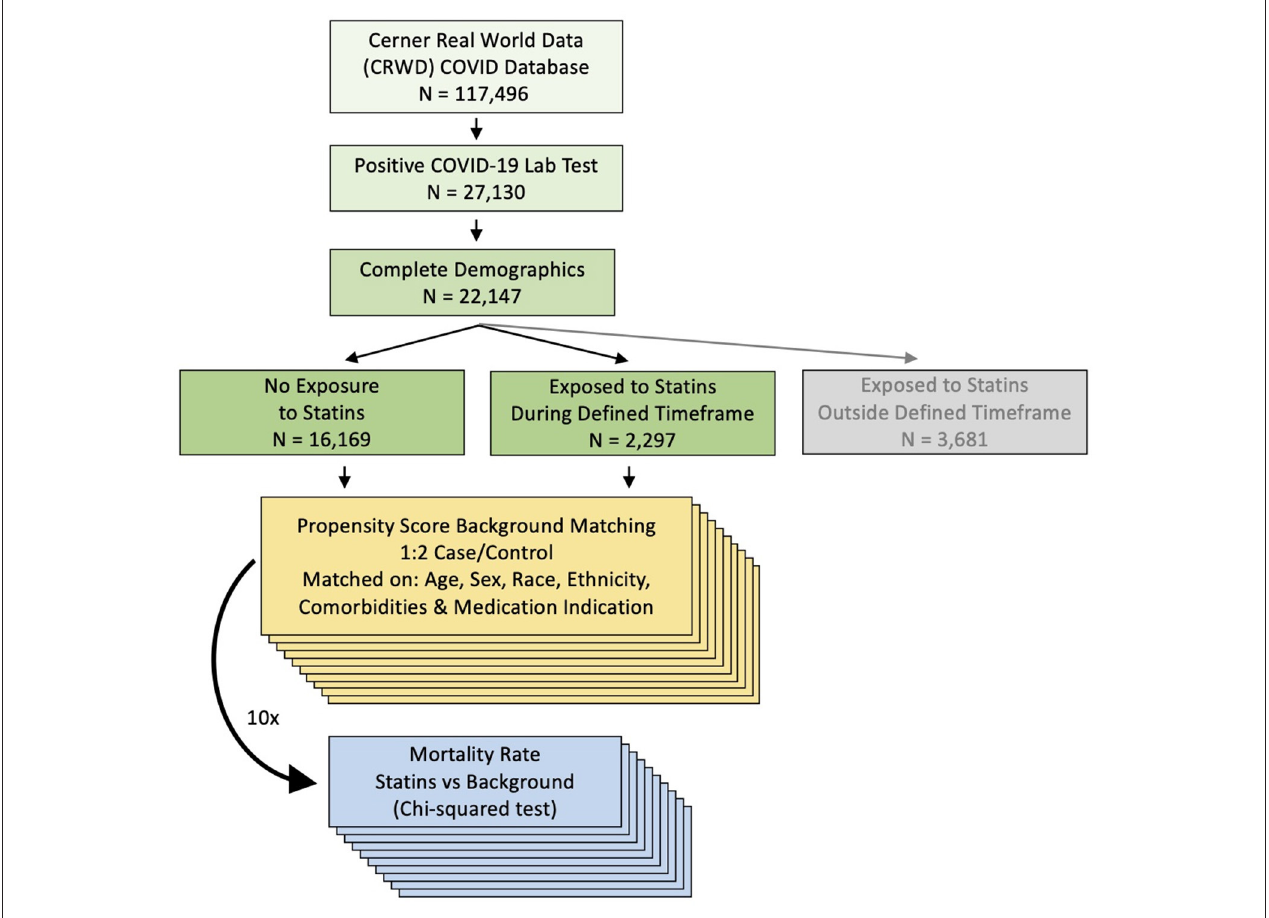
FIGURE 1 | Flow chart of the patient inclusion and the